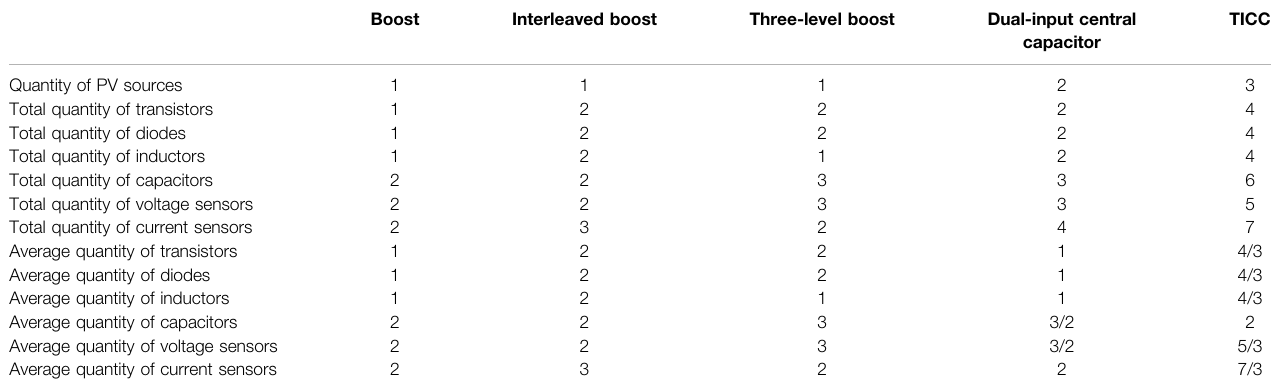
TABLE 2 | Comparison of device quantity.